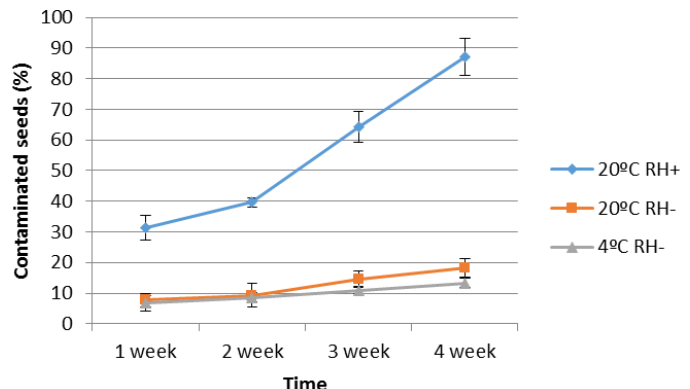
Figure 2. Percentage of P. radiata seeds contaminated by F. circinatum after incubating 100 disinfested seeds with one superficially inoculated seed. Incubation conditions were 20 °C with 25% or 65% of RH; and 4 °C and 20% RH. Each point is the average of three replicates. Bars are standard deviation.